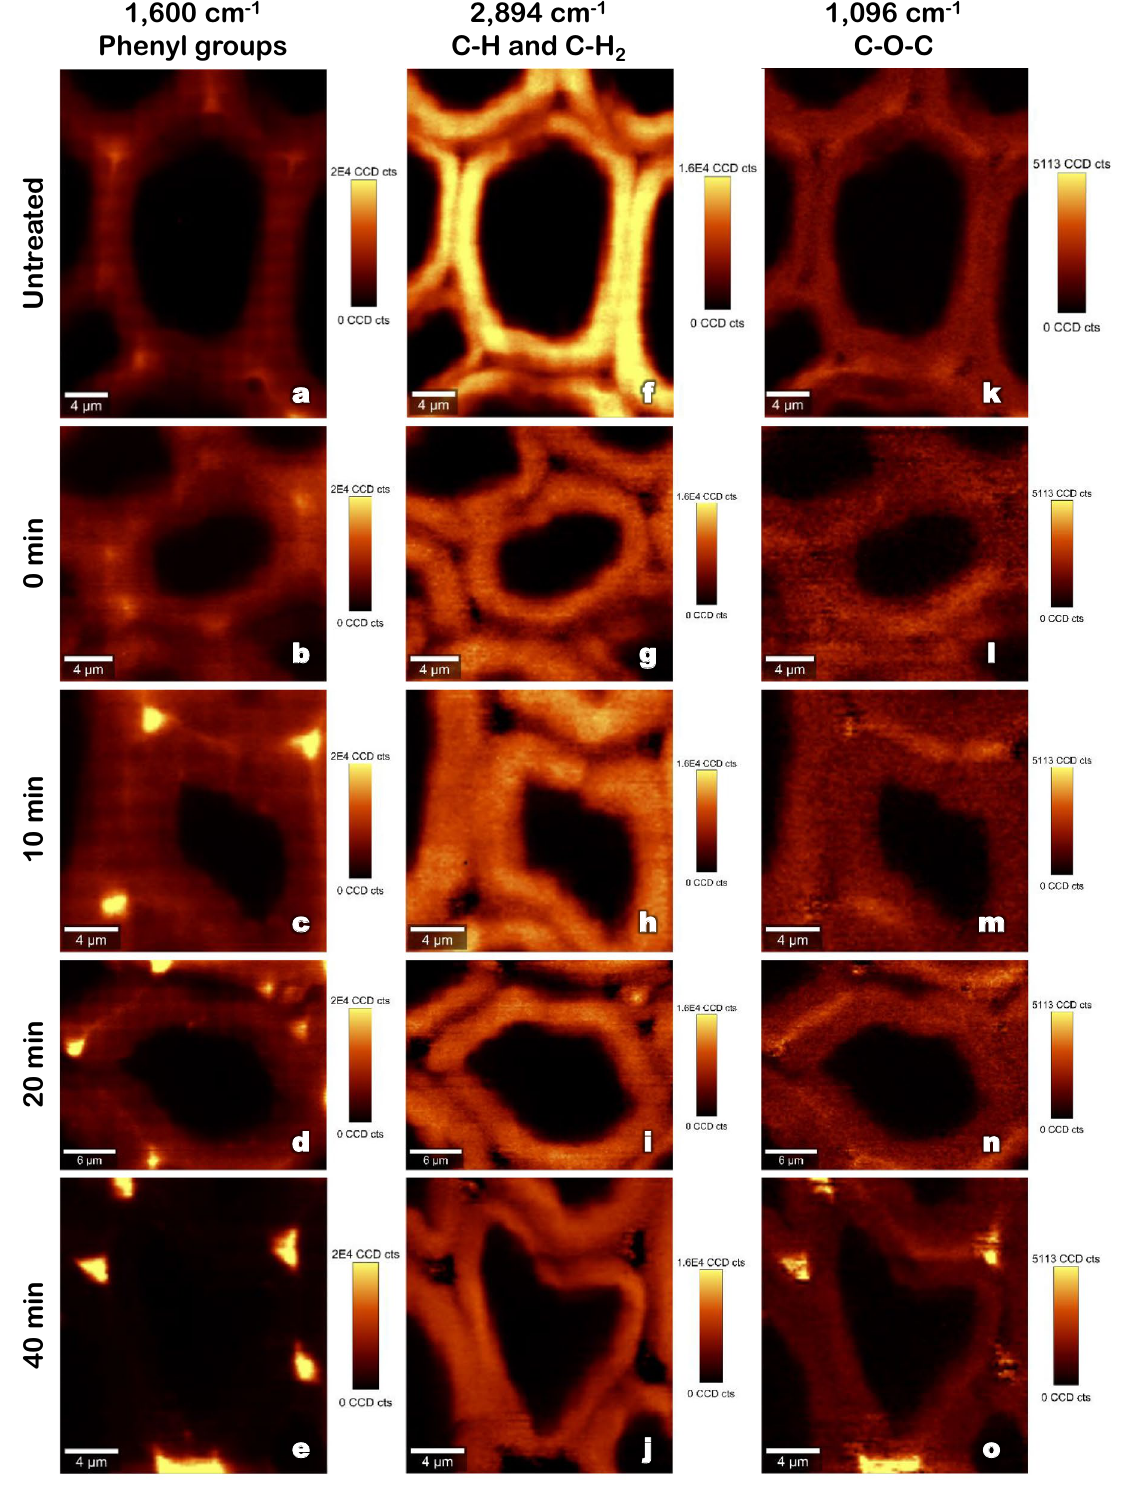
Figure 1. Raman images obtained by integration at different wavenumbers of untreated and hydrothermally treated poplar samples (160 °C) [Images were obtained with the help of Project FOUR software